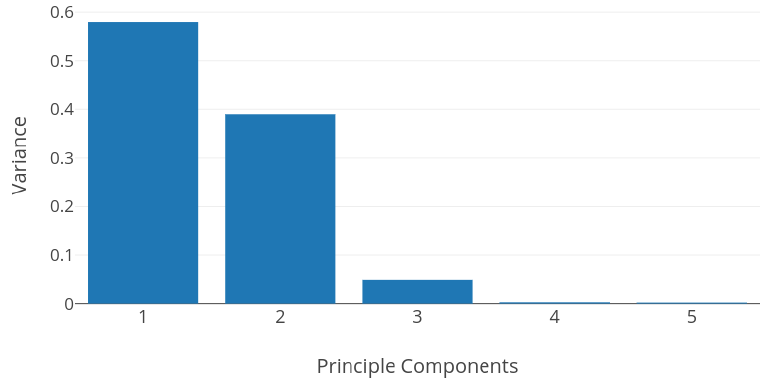
Figure 9. Principle components vs. variance. The first five principle components contribute to more than 98% of cumulative variance.